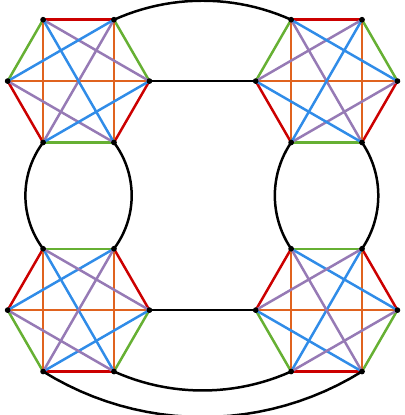
Figure 8. 6-colored graph corresponding to a non-melonic Feynman diagram whose exterior tensor contractions are equivalent to J 6